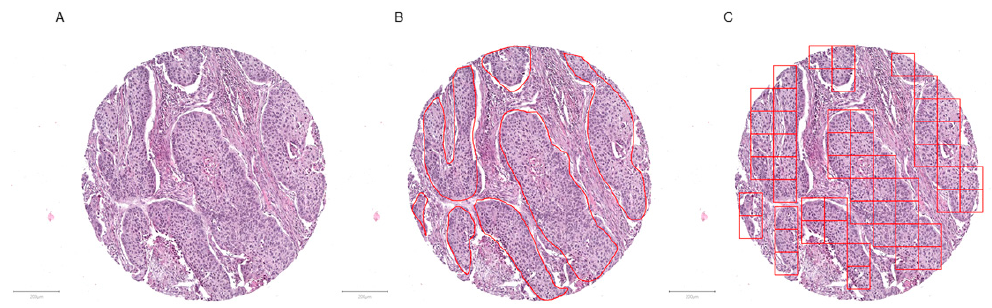
Figure 1. Tumor annotation and generation of image patches. Representative tissue microarray core of a squamous cell carcinoma without ( A ) and with annotation ( B , red outline), as well as after image patches creation ( C ). The image patches were subsequently saved as .png files. Magnification or scale bars: 200 µm